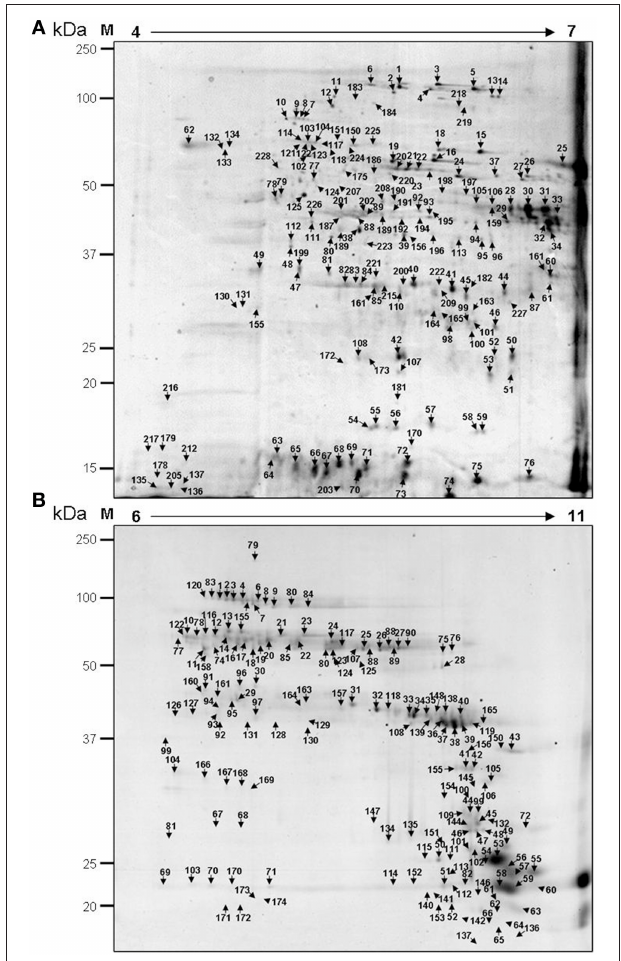
FIGURE 2 | Map of wheat grain nuclear protein spots. Comigration in 2-D electrophoresis of nuclear proteins extracted from grains harvested at six thermal time after anthesis. Proteins were loaded onto 13-cm IPG strips in the pH range 4–7 (A) and 6–11 (B) for isoelectric focusing in the first dimension and SDS-PAGE in the second dimension. M, molecular weight protein standards. Protein spots that were excised and analyzed by mass spectrometry are indicated.